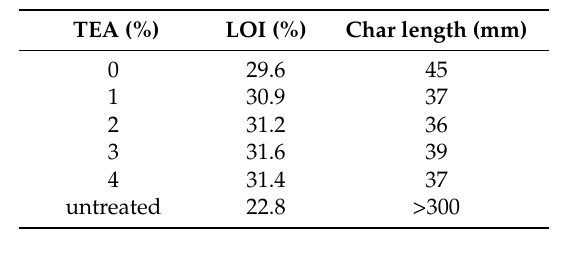
Table 7. LOI and vertical burning flammability of the Nomex ® /cotton blend fabric treated with 12% HFPO, 3% BTCA and TEA with different concentration, cured at 170 ◦ C for 3 min, and subjected to one regular wash followed by a second wash with 0.01% Ca(NO 3 ) 2 added.